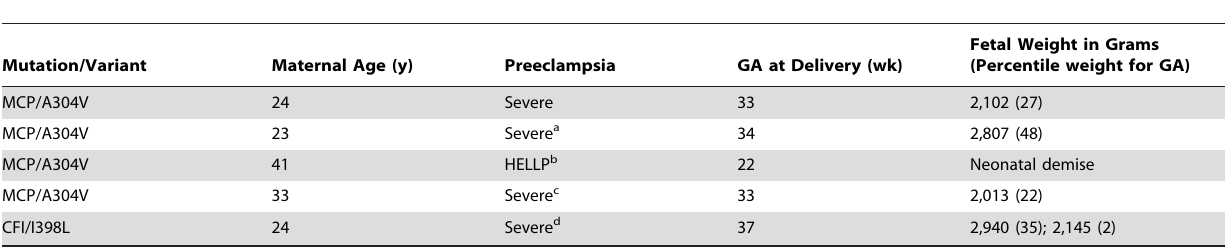
Table 3. Clinical characteristics of non-autoimmune preeclampsia patients with complement regulatory protein mutations.